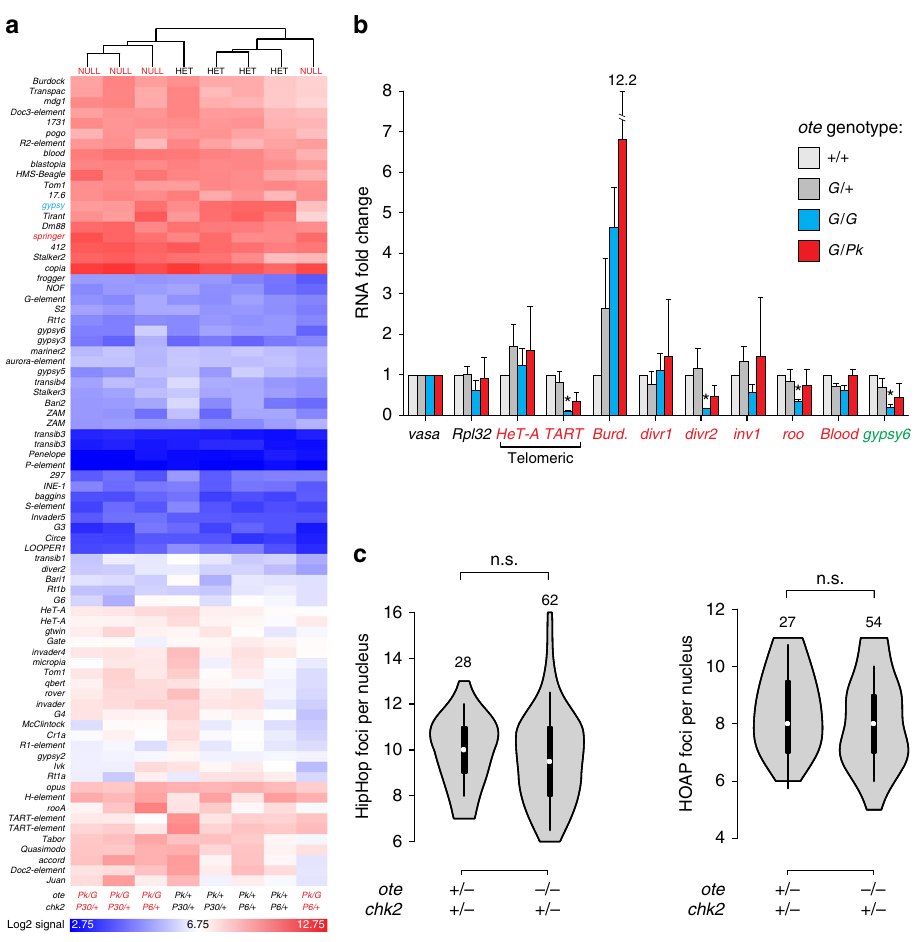
Fig. 5 Transposon transcription and telomere capping are unchanged in ote mutants. a Heat map of the log2 signal intensities of RNAs corresponding to D. melanogaster transposons (indicated to the left); unsupervised clustering reveals no segregation by genotype. The genotypes are shown below. b Quantitative RT-PCR analysis of transposon RNAs in the ovary. For Ote-containing genotypes (light and dark gray), ovaries were dissected from less than two-hour old females, and for ote null genotypes (blue and red), ovaries were dissected from 3-day-old females. Transposons analyzed are noted below (red indicates germline transposons and green indicates somatic transposons). RNAs were normalized to vasa and fold change is shown relative to ote + / + . Error bars indicate standard deviation from three biological replicates (* p < 0.05, Student ’ s t -test comparing RNAs from ote mutant ovaries to RNAs from ote B279G/ + ovaries). c Violin plots of the number of HipHop foci (left) or HOAP foci (right) per GSC nucleus in 1-day-old females. Numbers of GSCs analyzed are noted above each plot. Signi fi cance was assessed by Student ’ s t -test; n.s., not signi fi